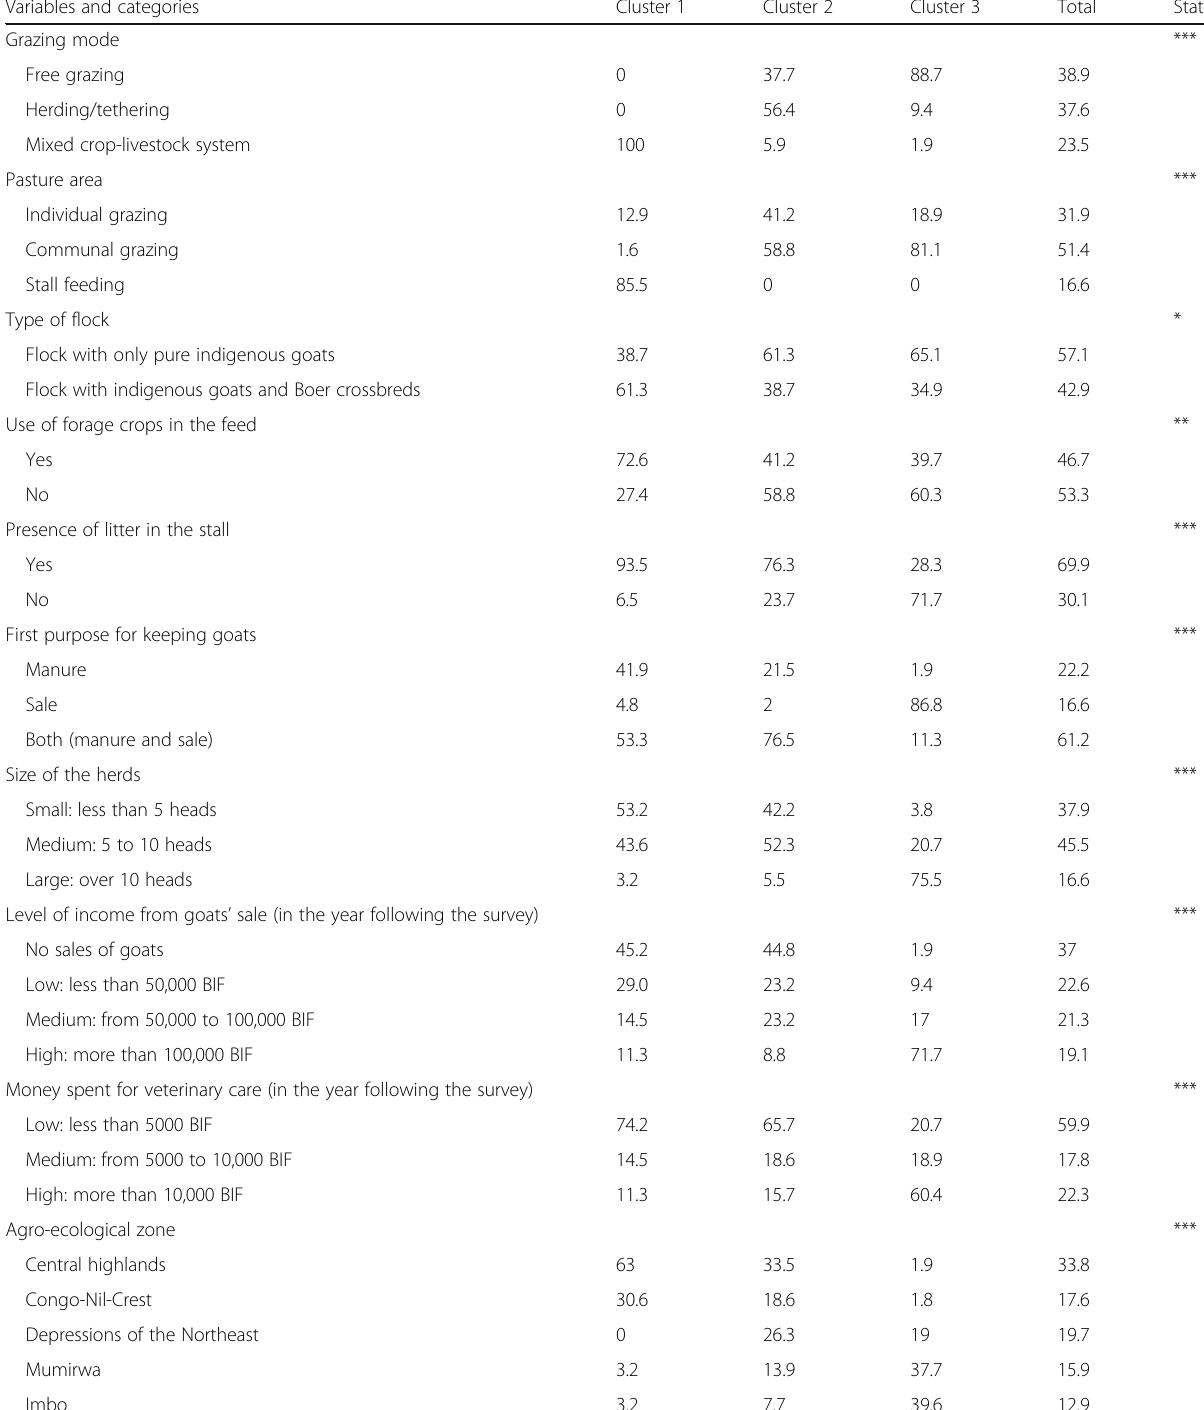
Table 2 Percentage of responders per categories for the three clusters identified by the hierarchical classification analysis Variables and